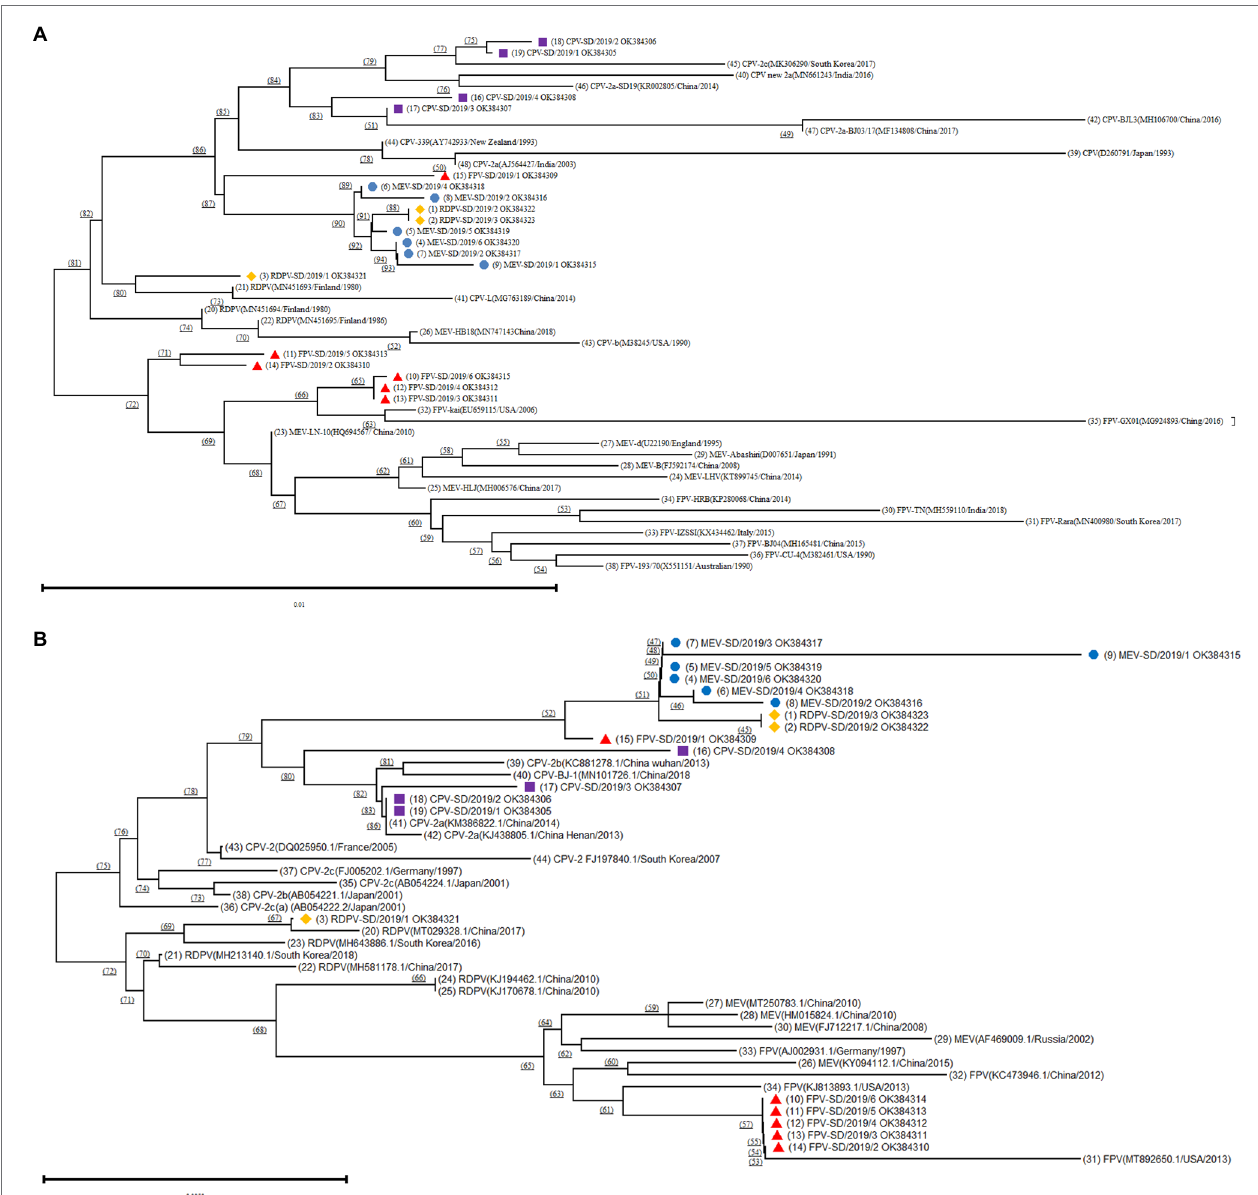
FIGURE 1 | Phylogenetic tree analysis based on the different FPV, canine parvovirus-2 (CPV-2), MEV, and RDPV isolates in the present study and reference isolates from GenBank. (A) Construction of the phylogenetic tree based on the near-complete genomes of the different isolates. (B) Construction of the phylogenetic tree based on the sequence of the VP2 gene of the different isolates. ■ Represents the CPVs isolated in this study; ▲ represents the FPVs isolated in this study; ● represents the MEVs isolated in this study; and ♦ represents the RDPVs isolated in this